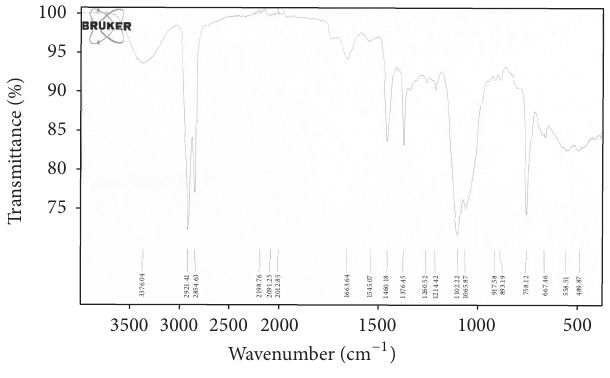
Figure 6: IR spectrum of hGDNT.